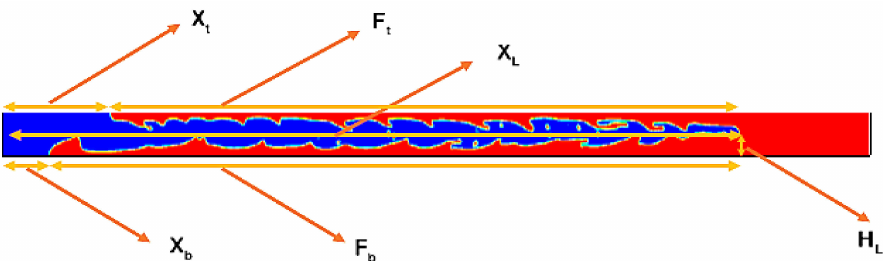
Figure 12. A schematic demonstration of the displacement shape. X t is the location of the invading fluid front at the top of the channel, and X b is a similar location at the bottom of the channel. X L is called the attacking front, which is the front of the finger-like structure in the longitudinal direction. f t and f b represent the length of the finger structure ( f t = X L − X t , f b = X L − X b ). H L is the height of the attacking